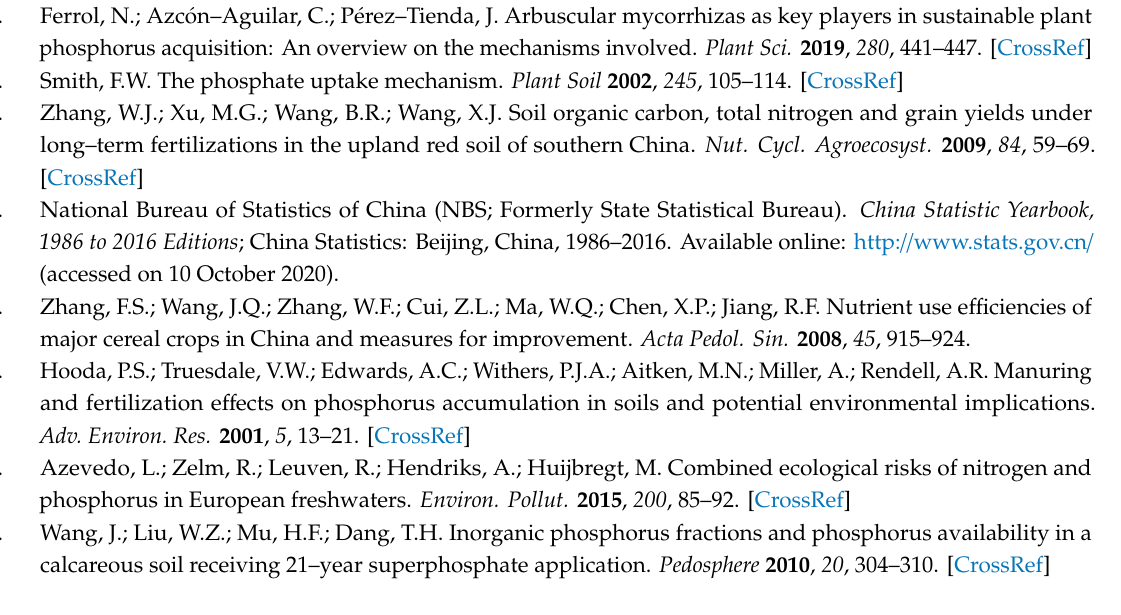
Figure S1: The change in chemical P input and use per area of cropland from 1986 to 2015 in China, Figure S2: Monthly dynamics of air temperature and precipitation in the study years in Zhaoan County, Fujian Province, China, Figure S3: Relationship between the sum of all the P fractions and Total-P (H 2 SO 4 -HClO 4 ) by analysis, Figure S4: Relationship between soil extractable Al / Fe and Al-P / Fe-P come from field